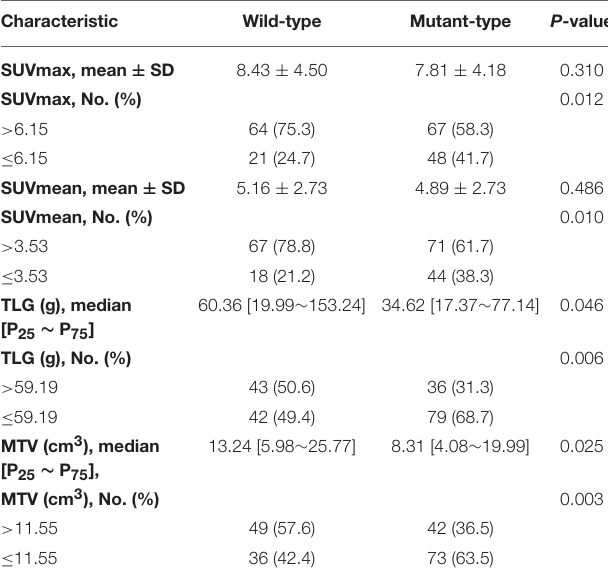
TABLE 2 | Association between metabolic parameters and epidermal growth factor receptor mutation status. Characteristic